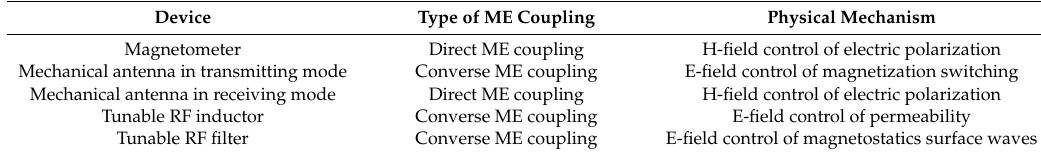
Table 1. Summary of the physical mechanisms for various of integrated multiferroic